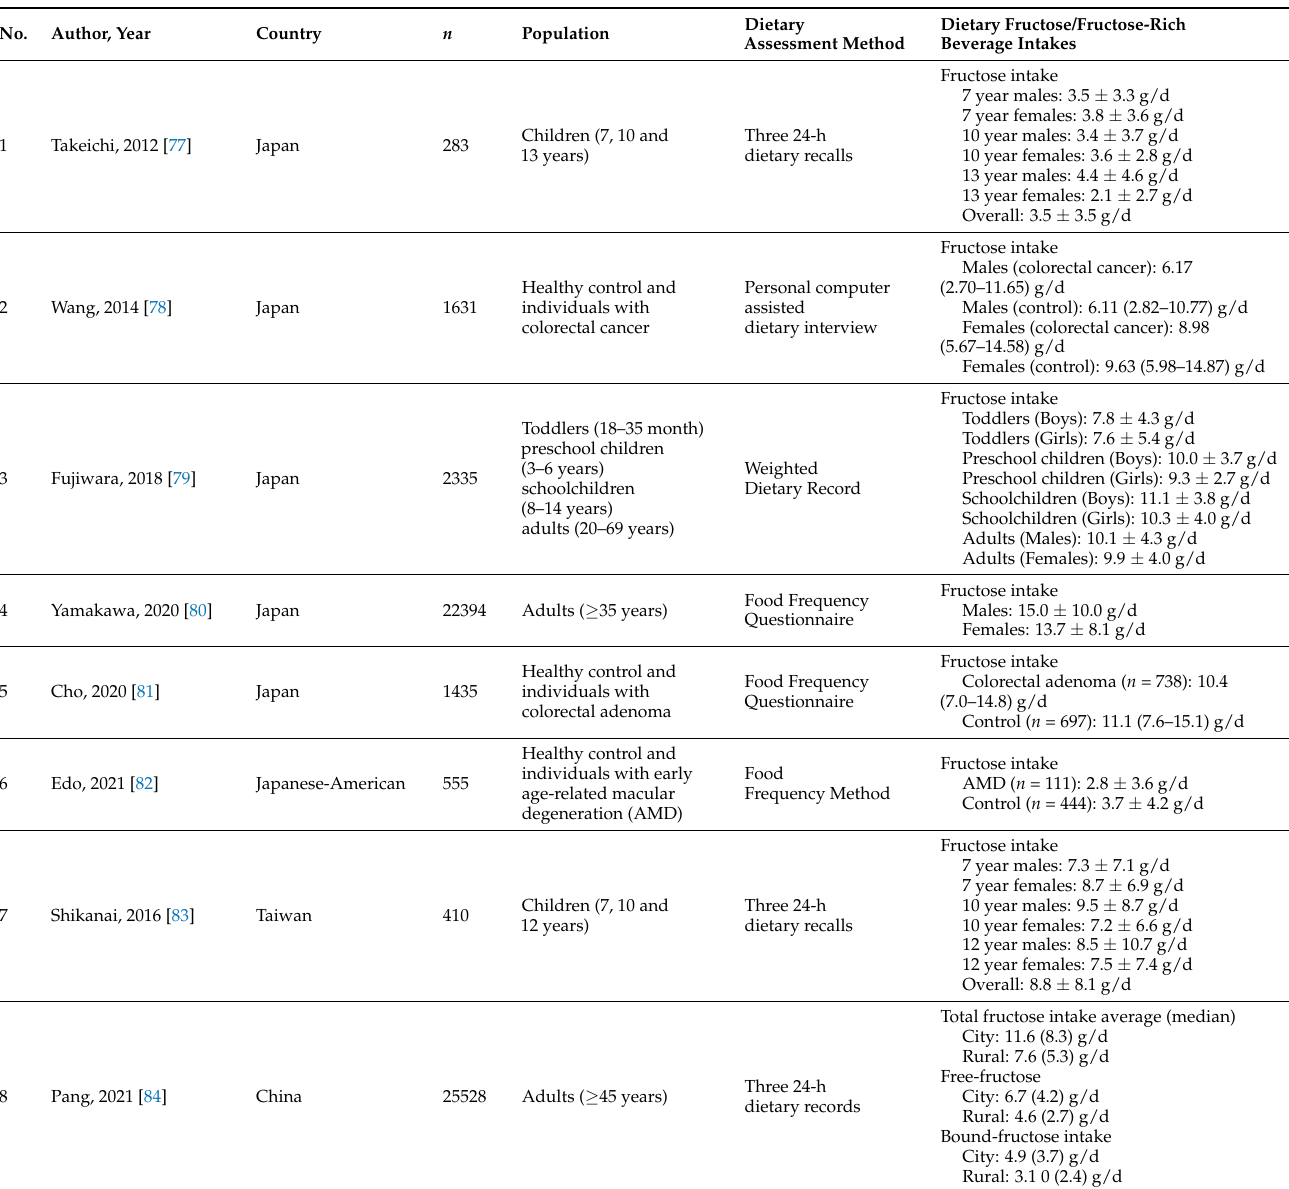
Table 2. Dietary fructose intake in Asian